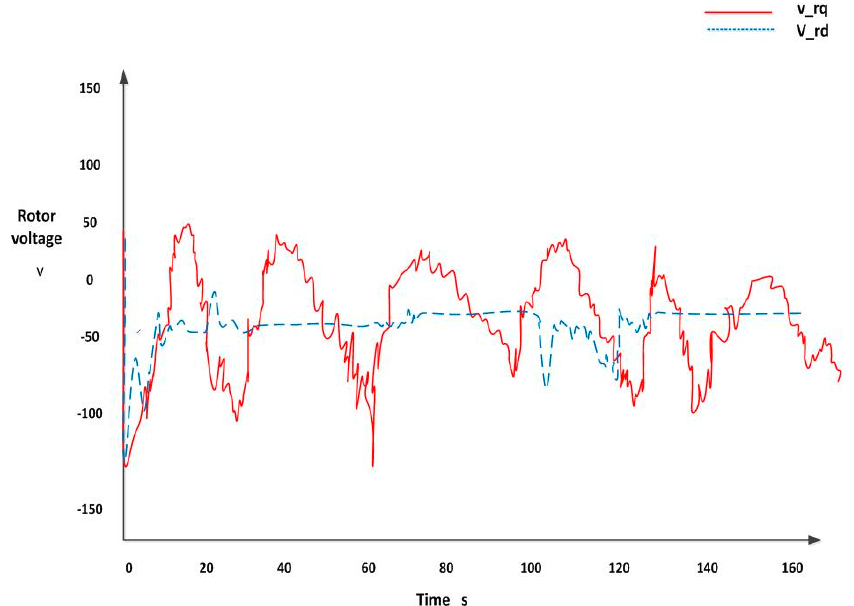
Figure 9. DFIG rotor speed estimation performance using AISE.